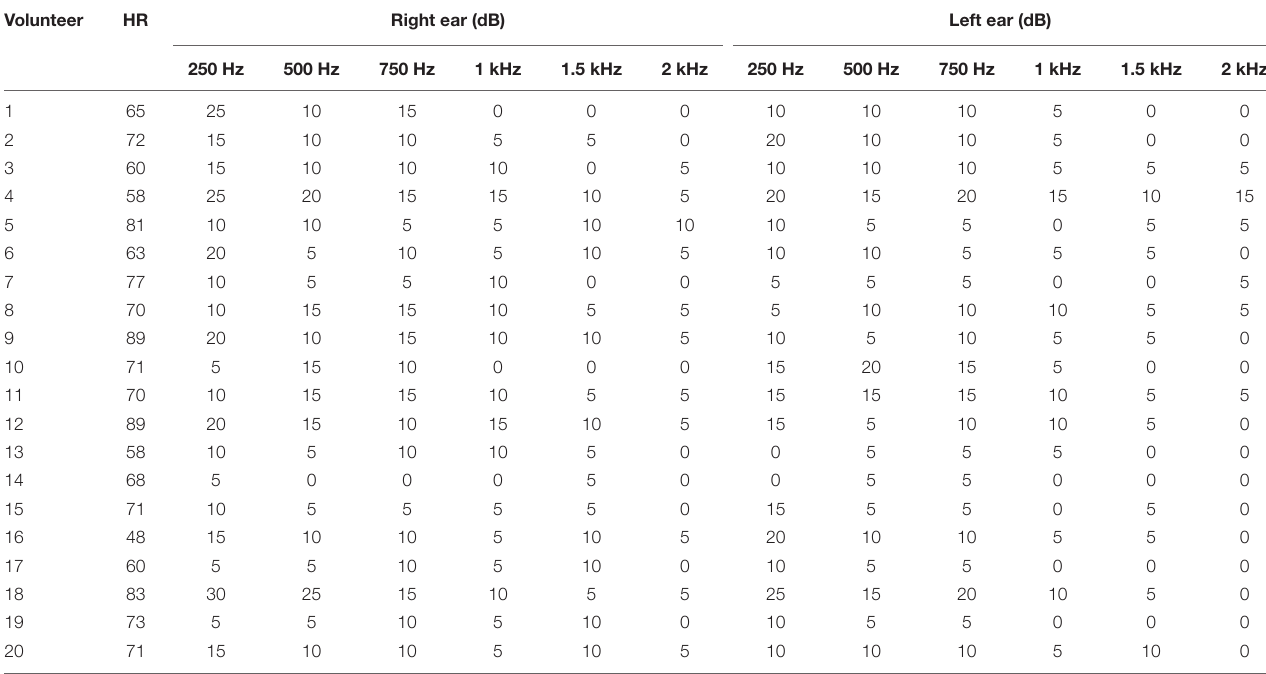
TABLE 2 | Heart rate (HR) and audiometry values per